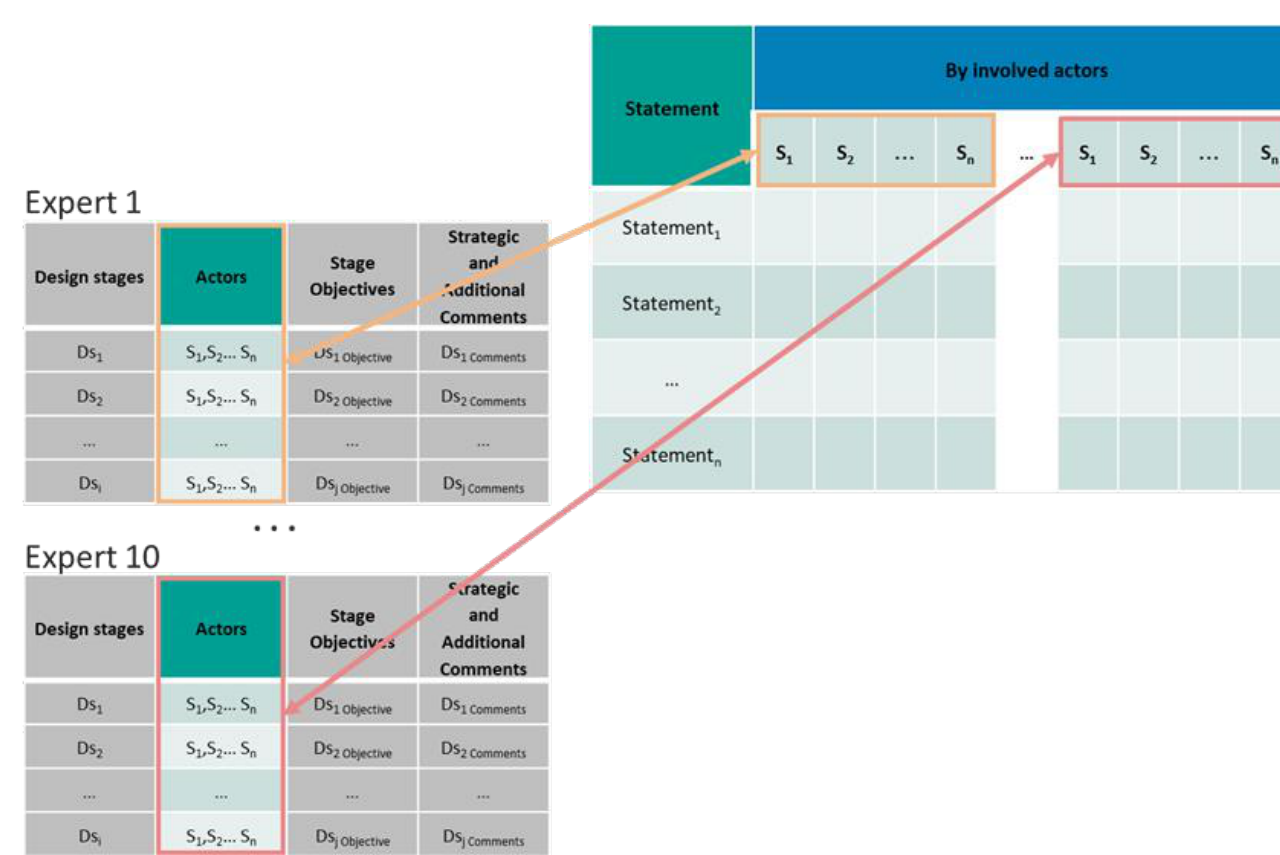
8 of 40 Figure 4. Multi-expert data compilation regarding the elements of the design process axis. 4.1.2. Elements on the Axis of Actors